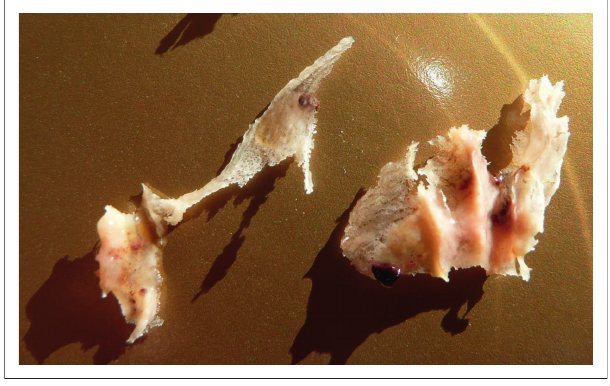
FIGURE 1: Necrotic nasal turbinates sneezed out by the patient during the second episode.